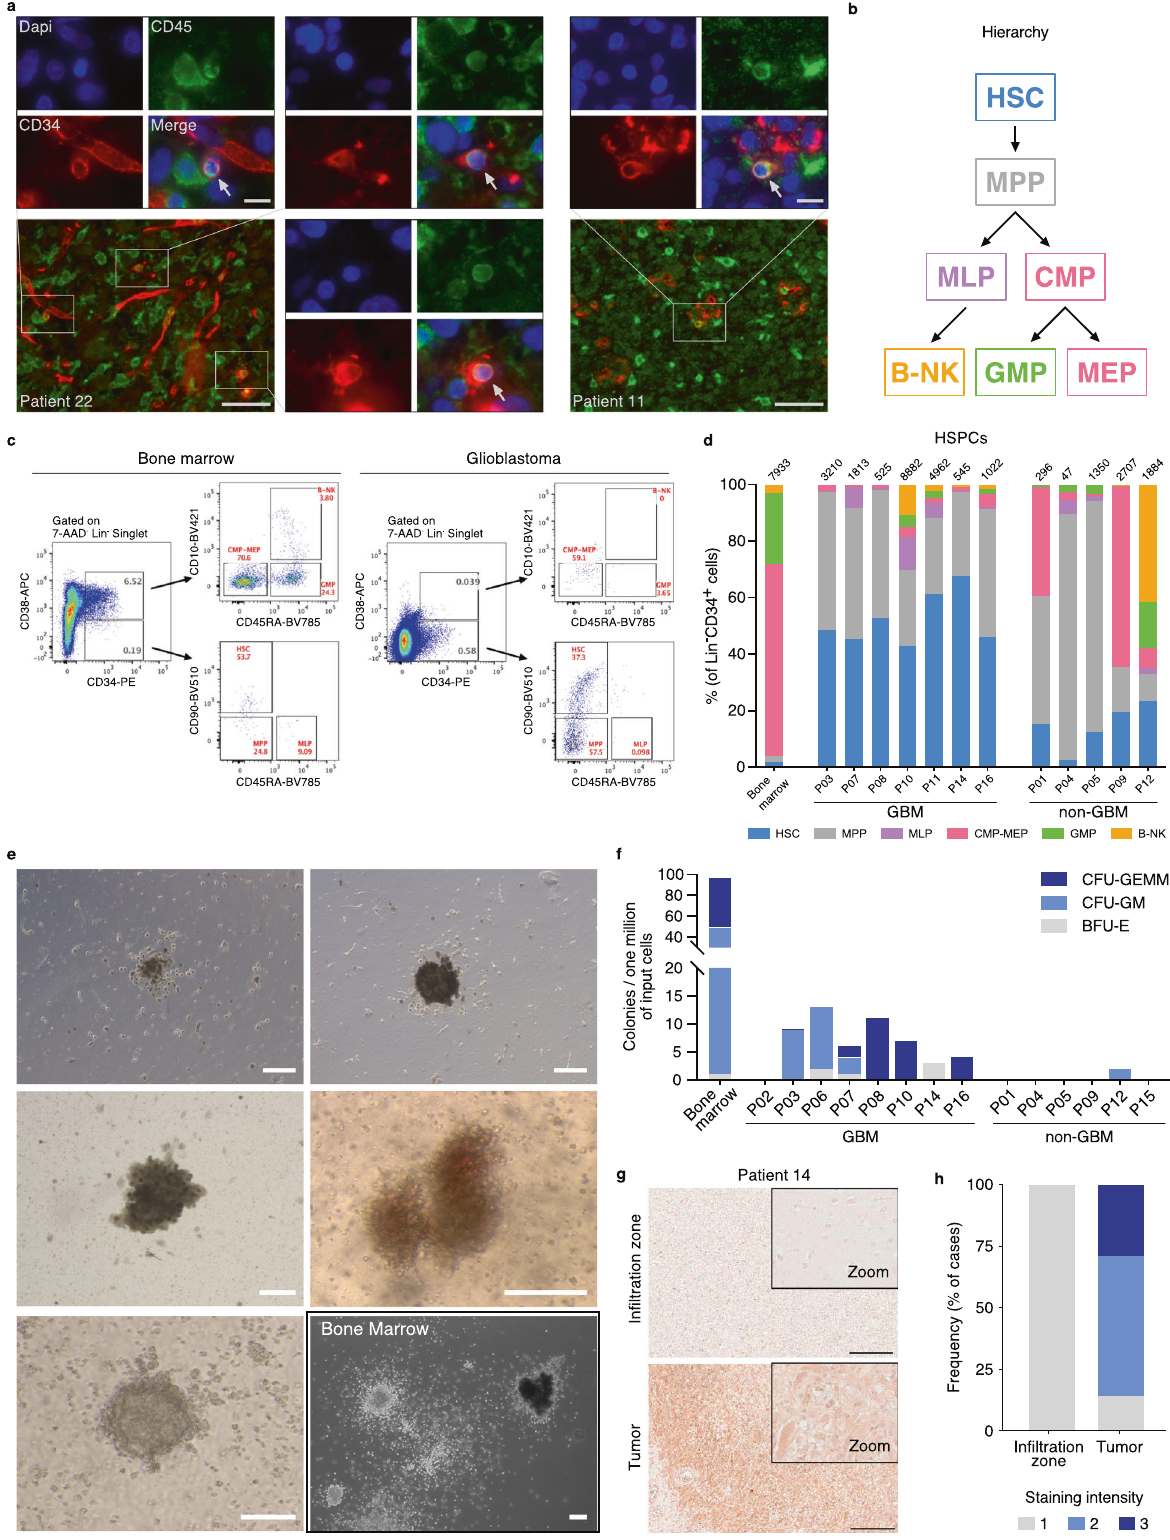
glioblastoma patients, in both the tumor core and the in fi ltration zone by immunohistochemistry. We observed increased CXCL12 expression in 6/7 glioblastoma tumor cores compared to the peripheral in fi ltration zone in the same section (Fig. 3g, h). Speci fi cally, CXCL12 was prominently detected in tumor cells with uniform staining patterns within samples. Tumor cells